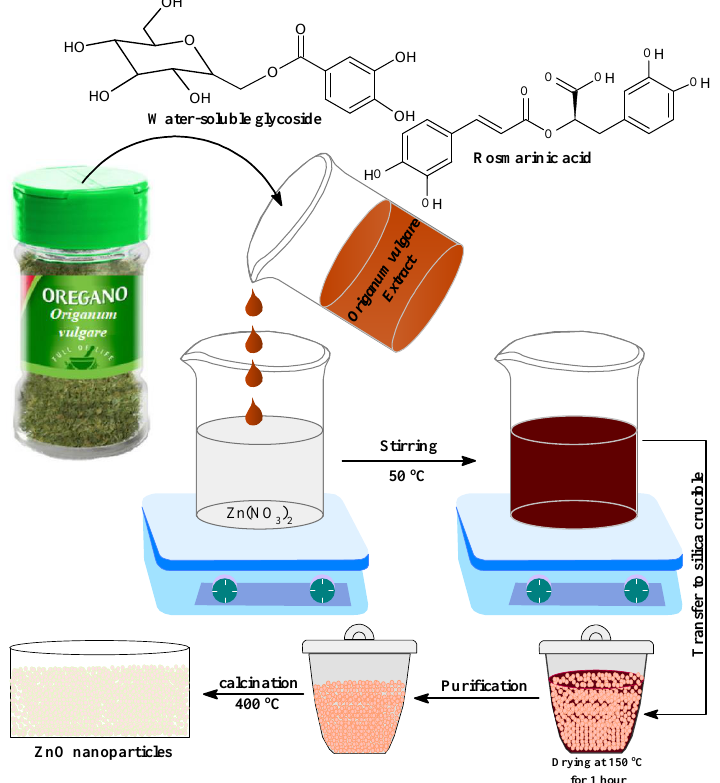
Figure 2. Reaction scheme for the synthesis of ZnO